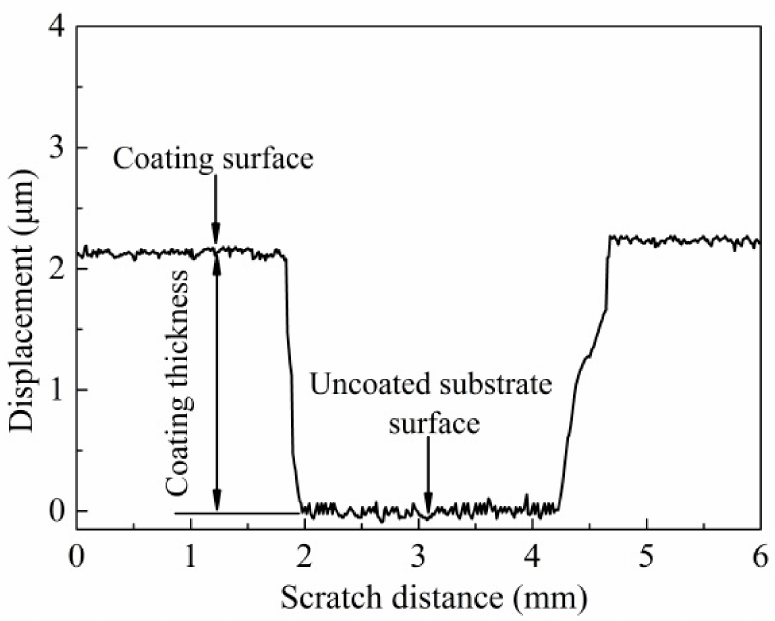
Figure 7. Coating thickness curve in the scratch test of the T180